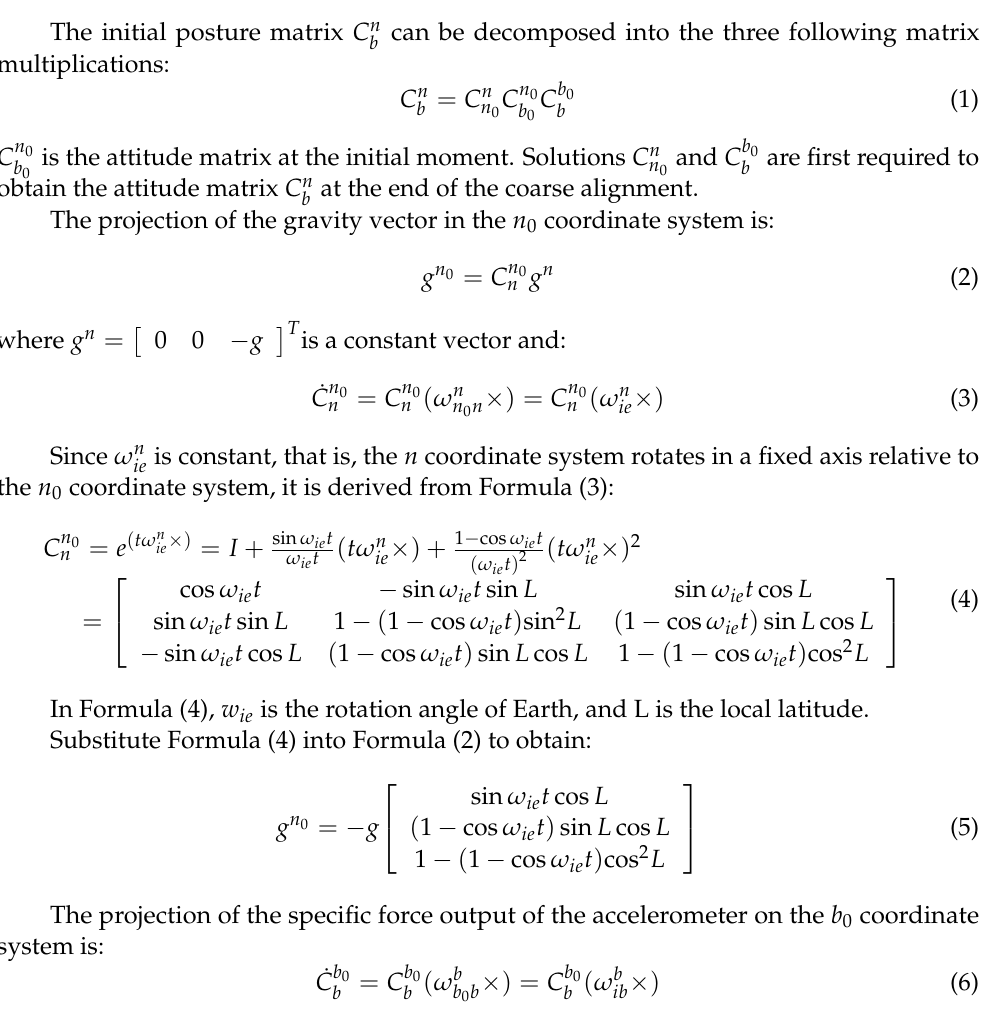
Figure 3. Observing gravity vectors in inertial space to form a conical